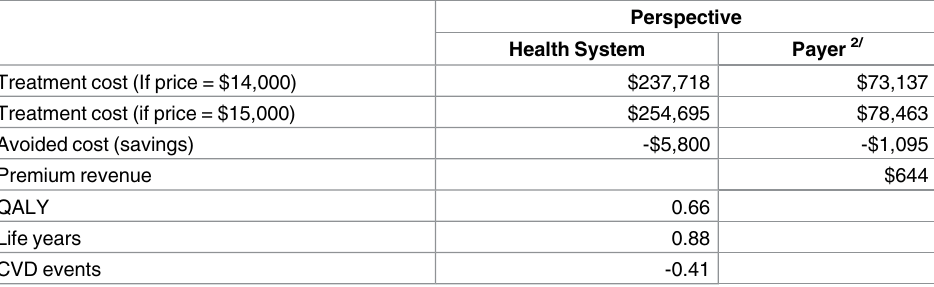
Table 2. Incremental Costs, Revenues and Outcomes with PCSK9 (Per Patient. Health System’sand Payer’sPerspective) 1/